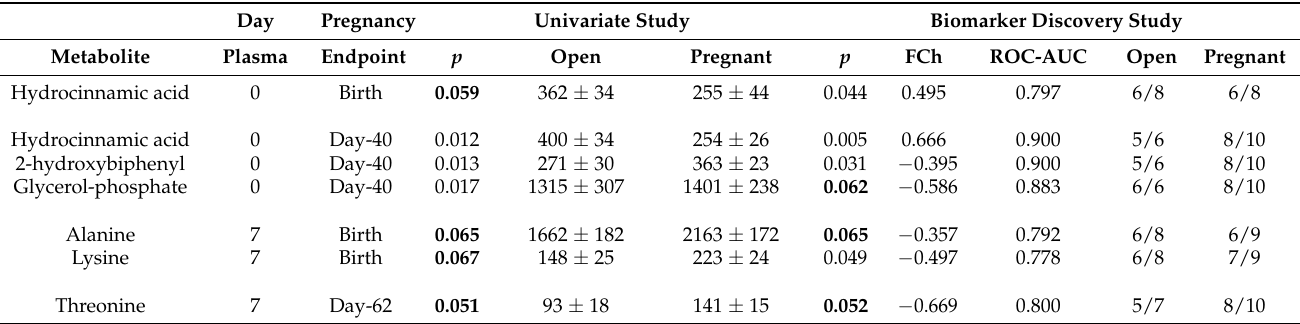
Table 2. Univariate analysis and biomarker identification studies (ROC-AUC) of candidate metabolites in plasma collected on Day-0 ( N = 16) and Day-7 ( N = 17) from Holstein recipients transferred with vitrified/warmed embryos and diagnosed at pregnancy endpoints Day 40, Day 62, and